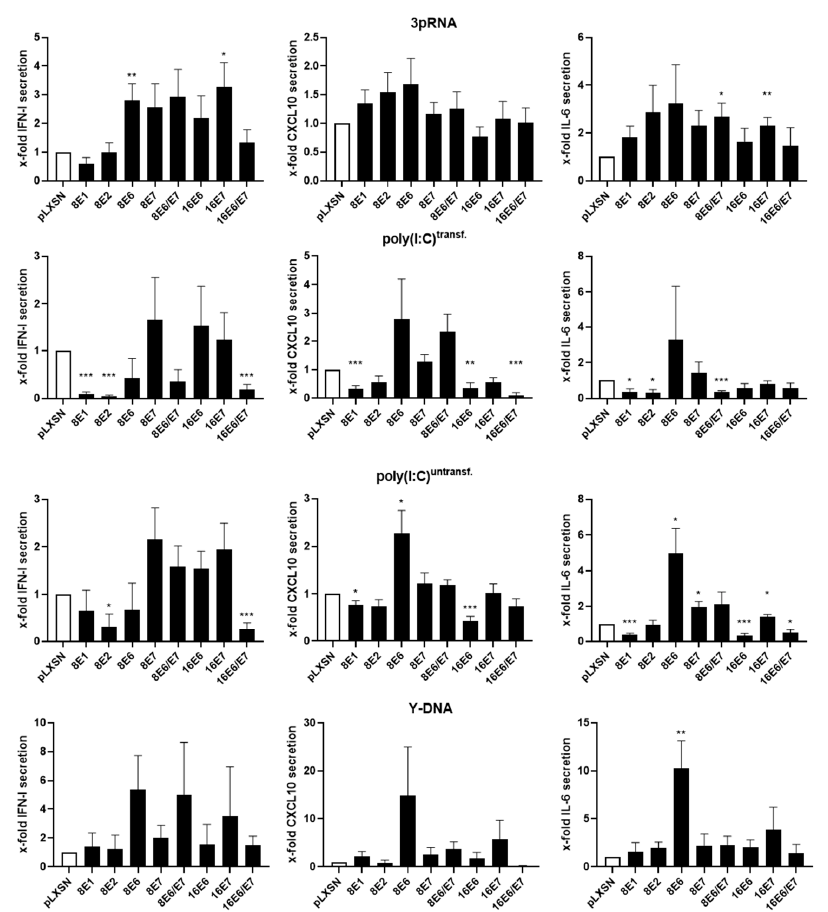
Figure 4. Expression of HPV8- E1 and HPV8- E2 decreases poly(I:C)-induced cytokine secretion in primary keratinocytes. Human primary keratinocytes, stably transduced with retroviral vectors expressing either the empty vector (pLXSN), HPV8 early genes, or HPV16 early genes, were trans- fected with 3pRNA (RIG-I ligand), Y-DNA (STING ligand), or poly(I:C) (MDA-5 ligand) or